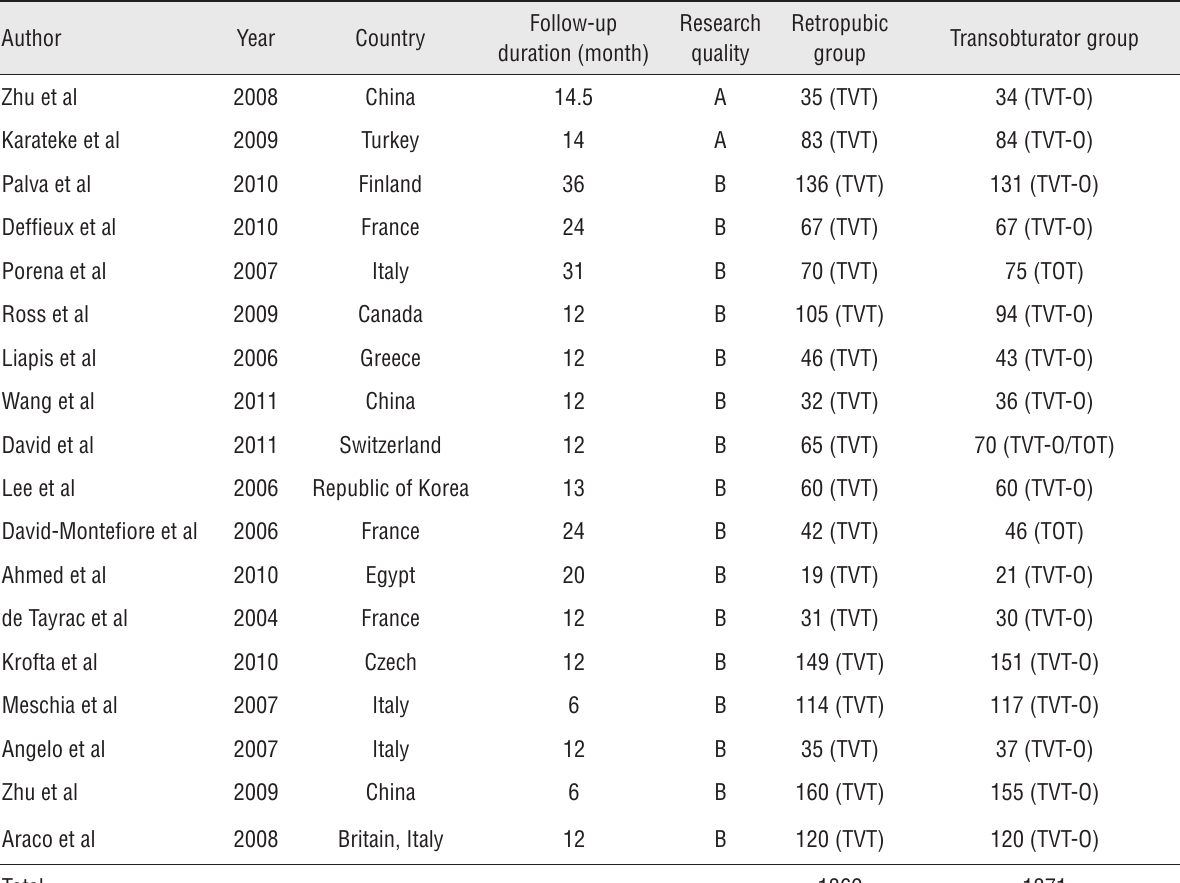
Table 1 - Basic data of research from